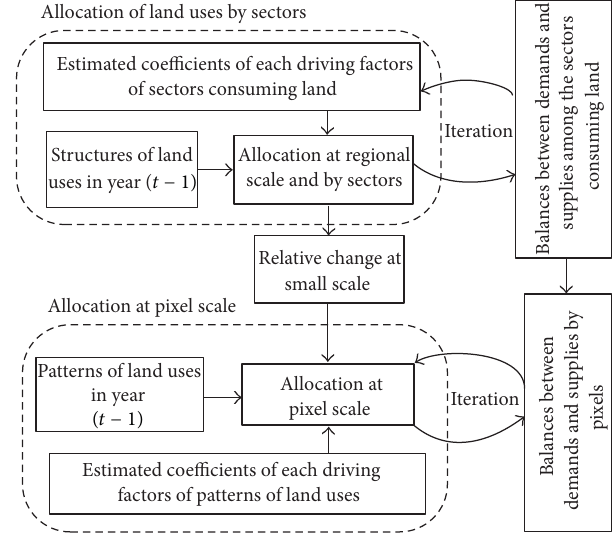
Figure 3: Space spatial distribution pattern of various land use types under the regional